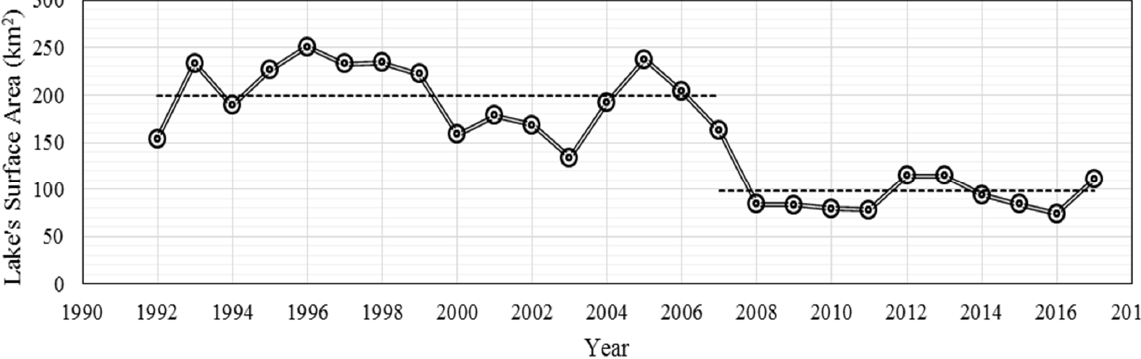
Figure 5. Annual average of Maharlou Lake’s surface area.